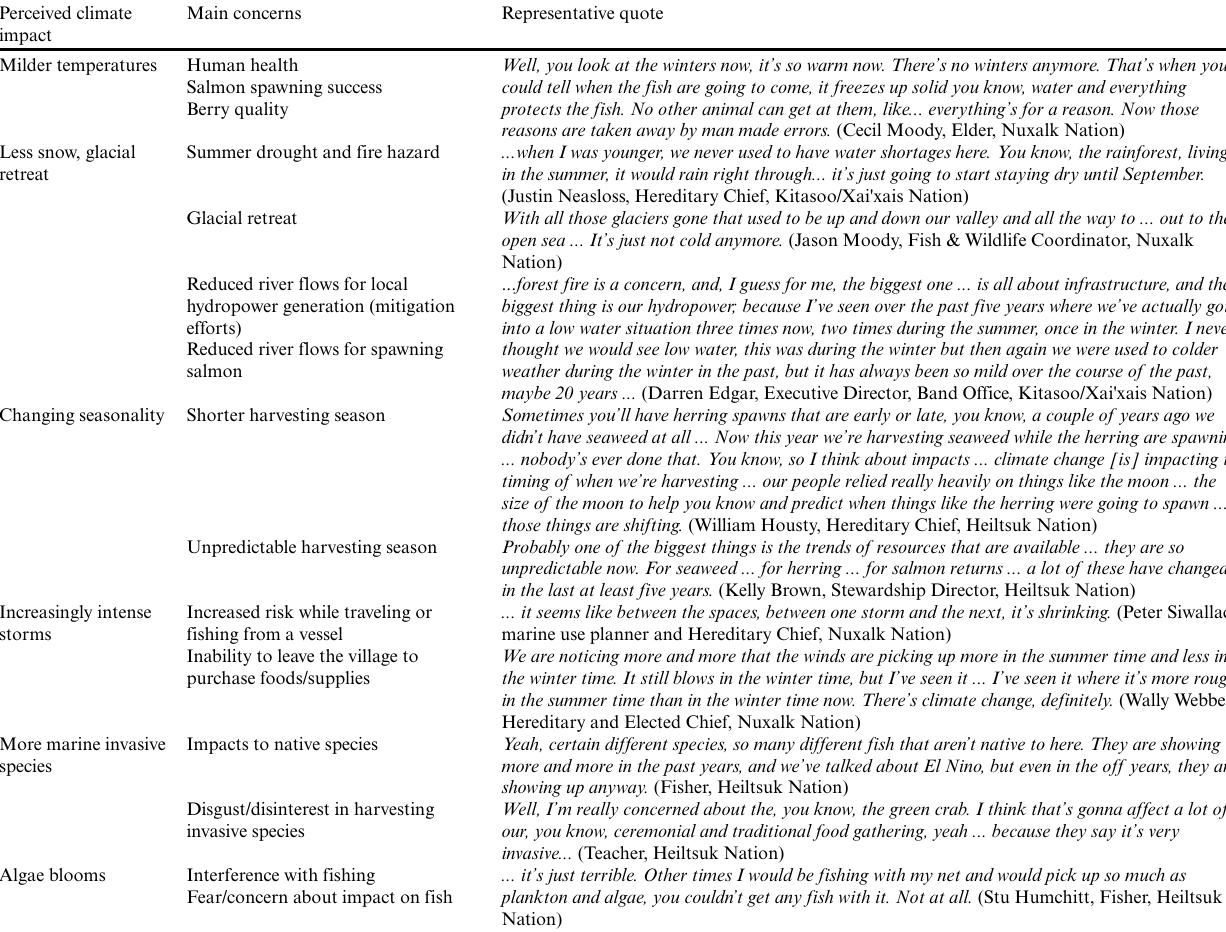
Table 1 . Perceived climate impacts on the marine and coastal environment. Quotes without direct attributions are anonymous.